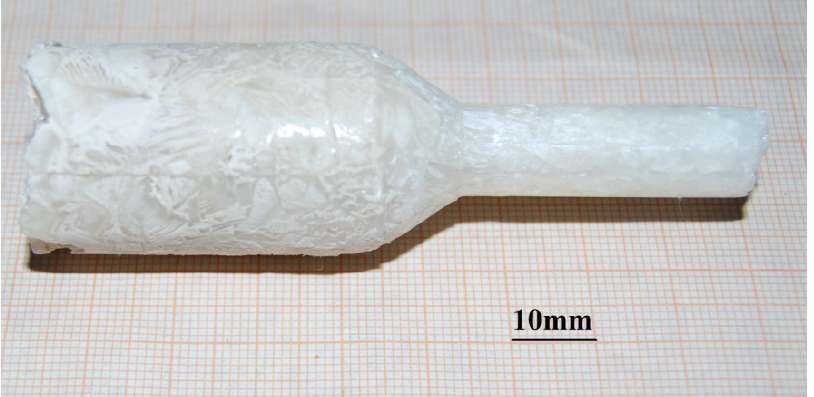
Na )NbO (KNN) crystals grown by the modified Bridgman method. x 1 − x 3